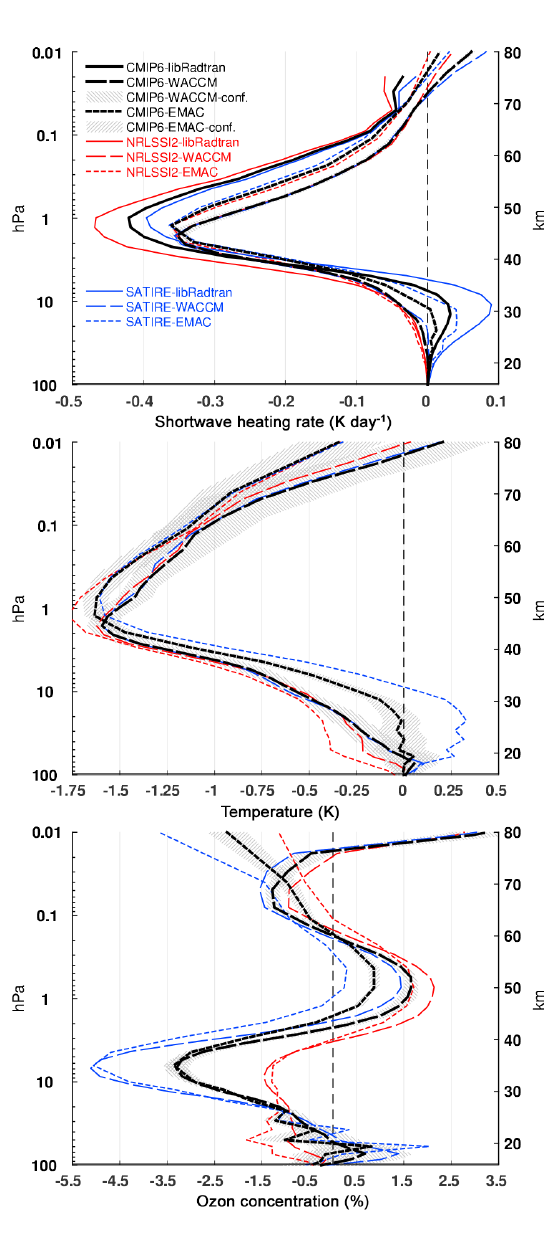
Figure 6. Impact of solar forcing for perpetual solar-minimum con- ditions according to CMIP6 (black) as well as constituent NRLSSI2 (red) and SATIRE (blue) datasets on climatological (annual mean) profiles of SW heating rates (top), temperature (center), and ozone concentrations (bottom) averaged over the tropics (25 ◦ S–25 ◦ N) when compared to NRLSSI1(CMIP5) solar forcing; derived from simulations with CESM1(WACCM) (long-dashed), EMAC (short- dashed), and libradtran radiative transfer calculations (solid, only top panel) only shown for SW heating rates; 95% confidence inter- vals for CMIP6 simulations (hatched) estimated by bootstrapping.